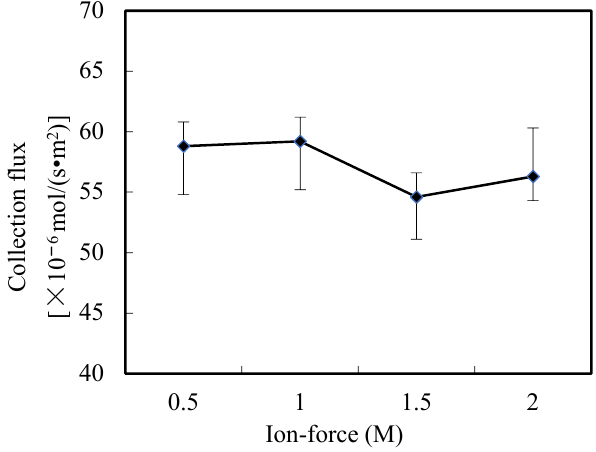
Figure 11. Influence of ion-force on collection of Ho(III).